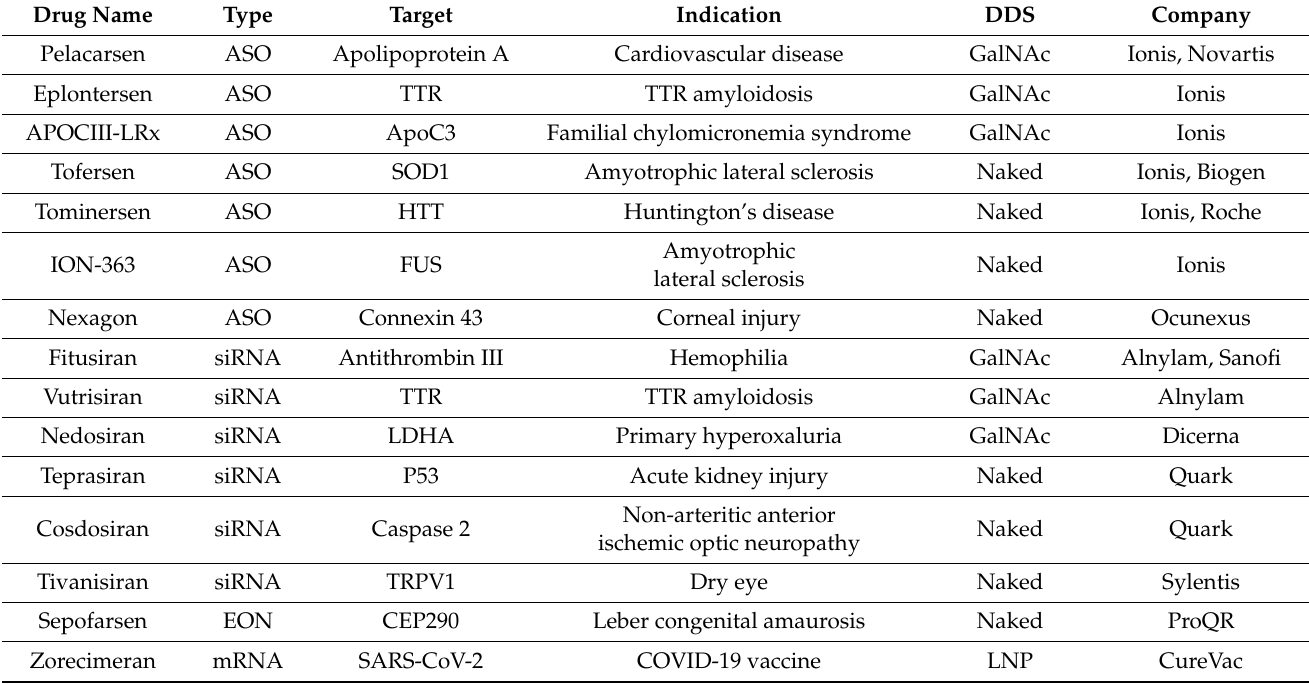
Table 3. Nucleic acid drugs in a phase 3 trial (as of 30 June